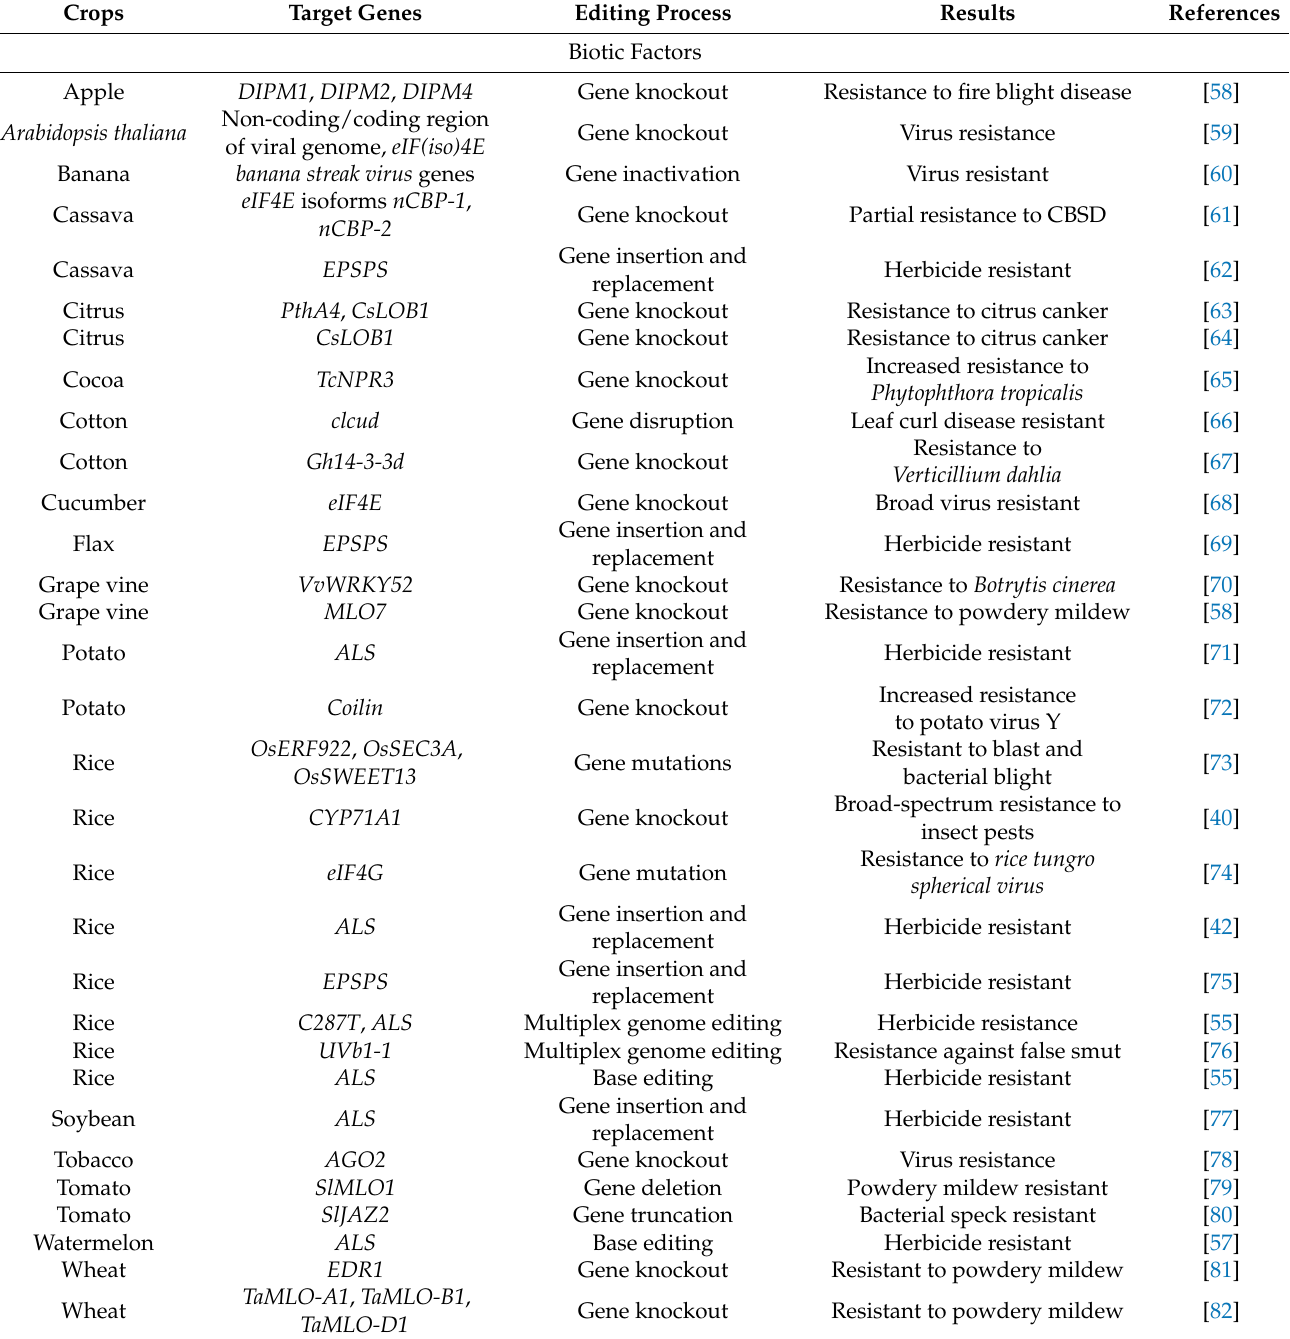
Table 5. The application of CRISPR–Cas in plant biotechnology. Abbreviations: CBSD, Cassava brown streak disease; PUFA, polyunsaturated fatty